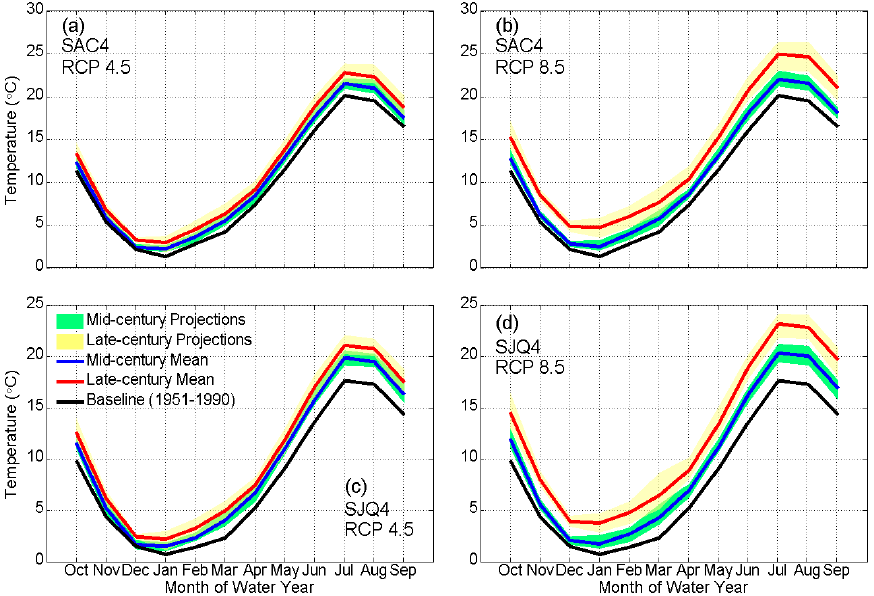
Figure 10. Monthly temperature projections for Sacramento Four Rivers ( a , b ) as well as San Joaquin Four Rivers ( c , d ) under RCP 4.5 and RCP 8.5 projections,